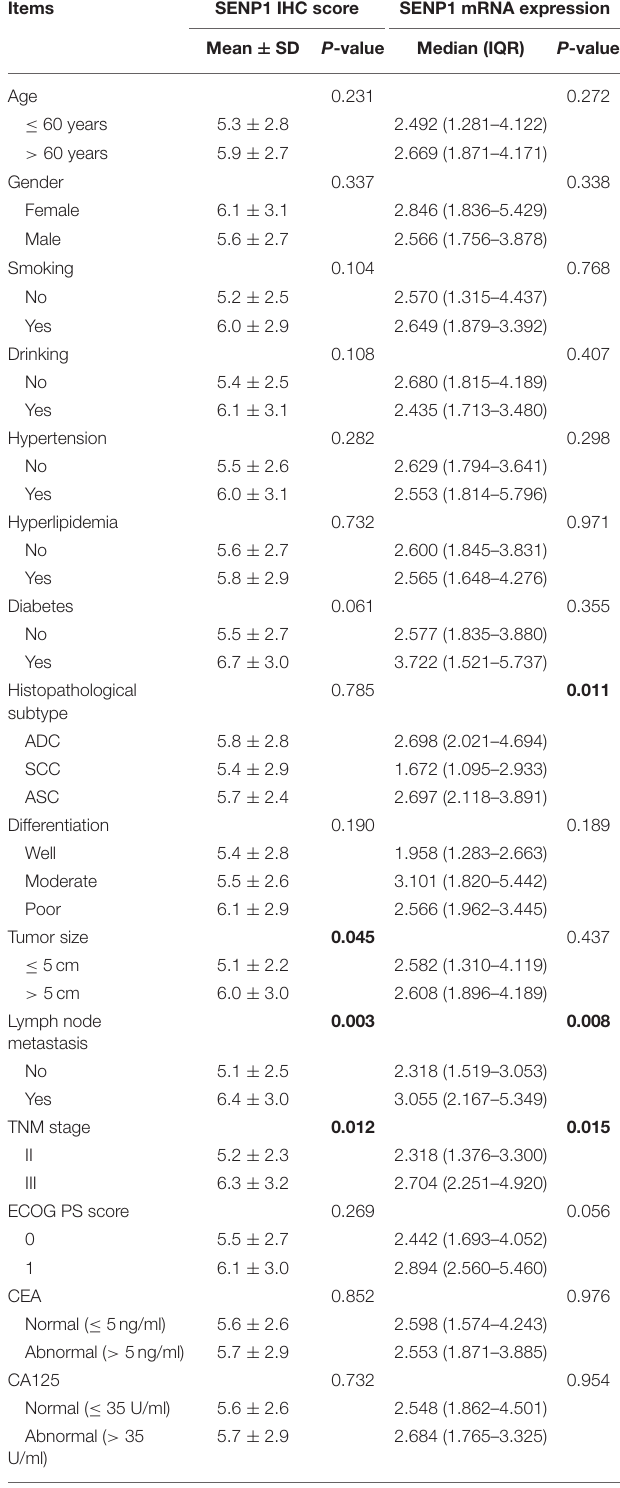
TABLE 2 | Correlation between SENP1 expression and clinical characteristics.